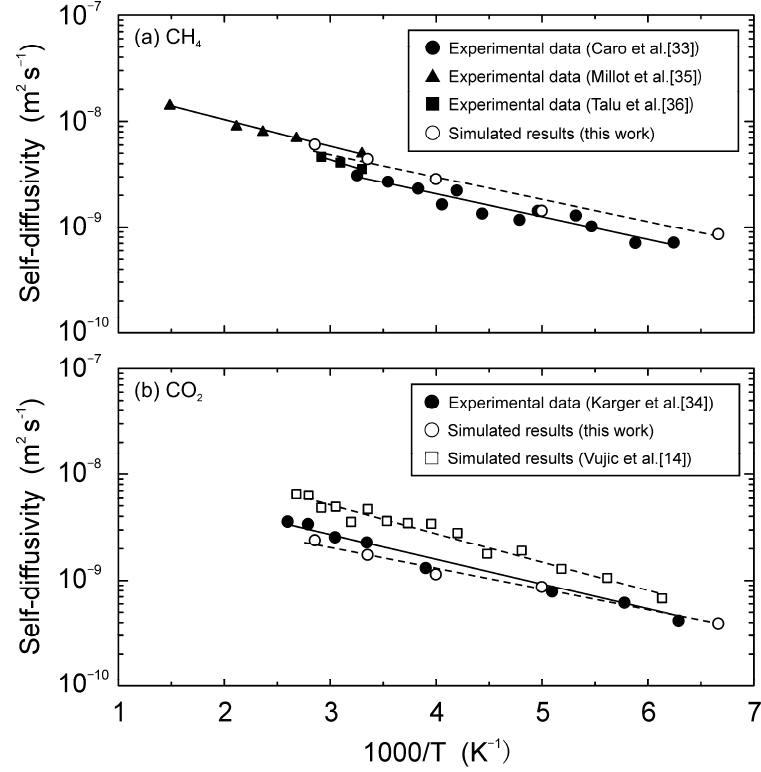
Figure 9. Effects of temperatures on the self-diffusivities of ( a ) CH 4 and ( b ) CO 2 .